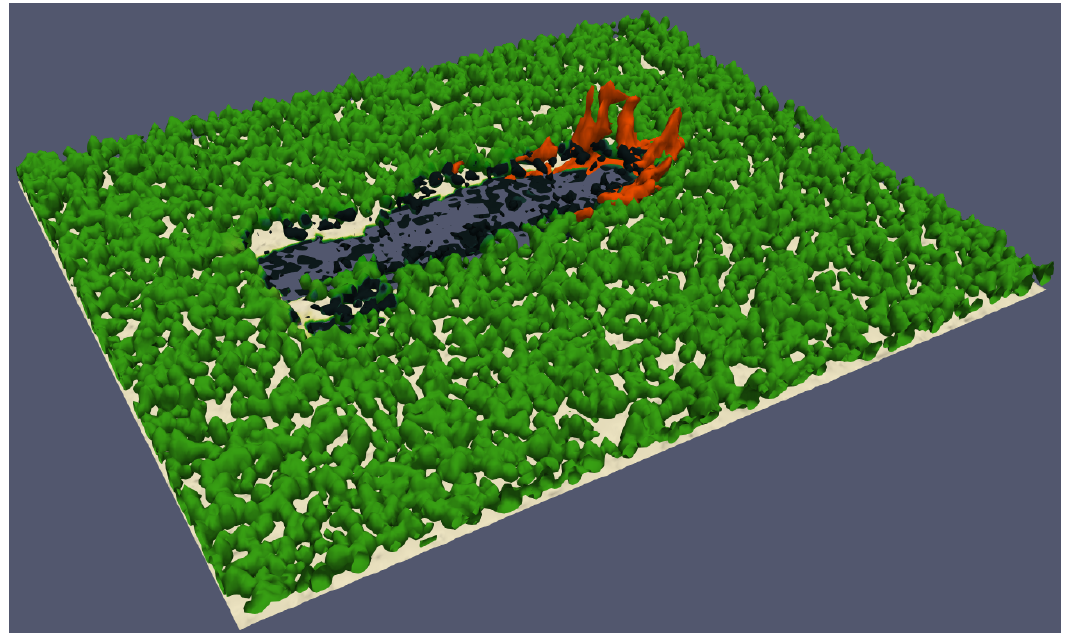
Figure 1. Sample simulation output showing the three-dimensional view of fire spread in the fuel continuum, using the 25% thinning fixed moisture case as an example. Green indicates unburnt canopy, and orange indicates the flame